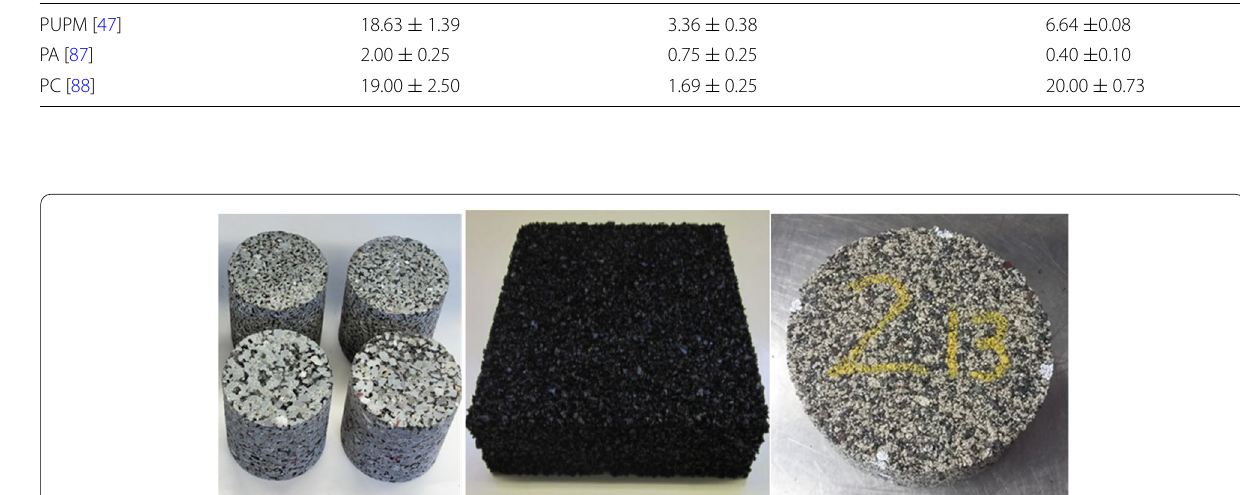
Table 1 Mechanical properties between PUPM and conventional porous pavement materials Type of mixture